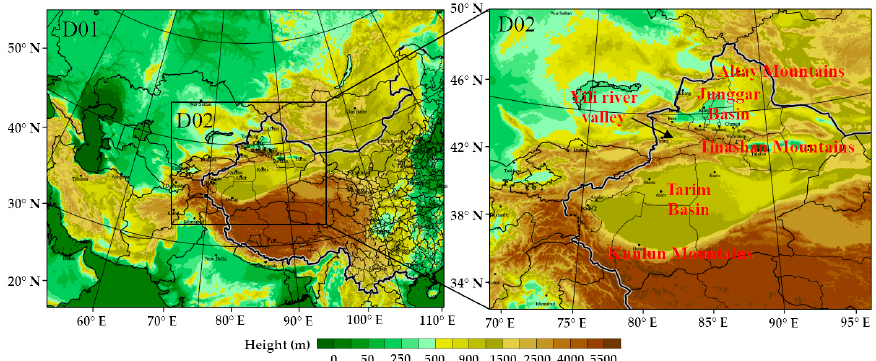
Figure 1. Two nested domains and topography.